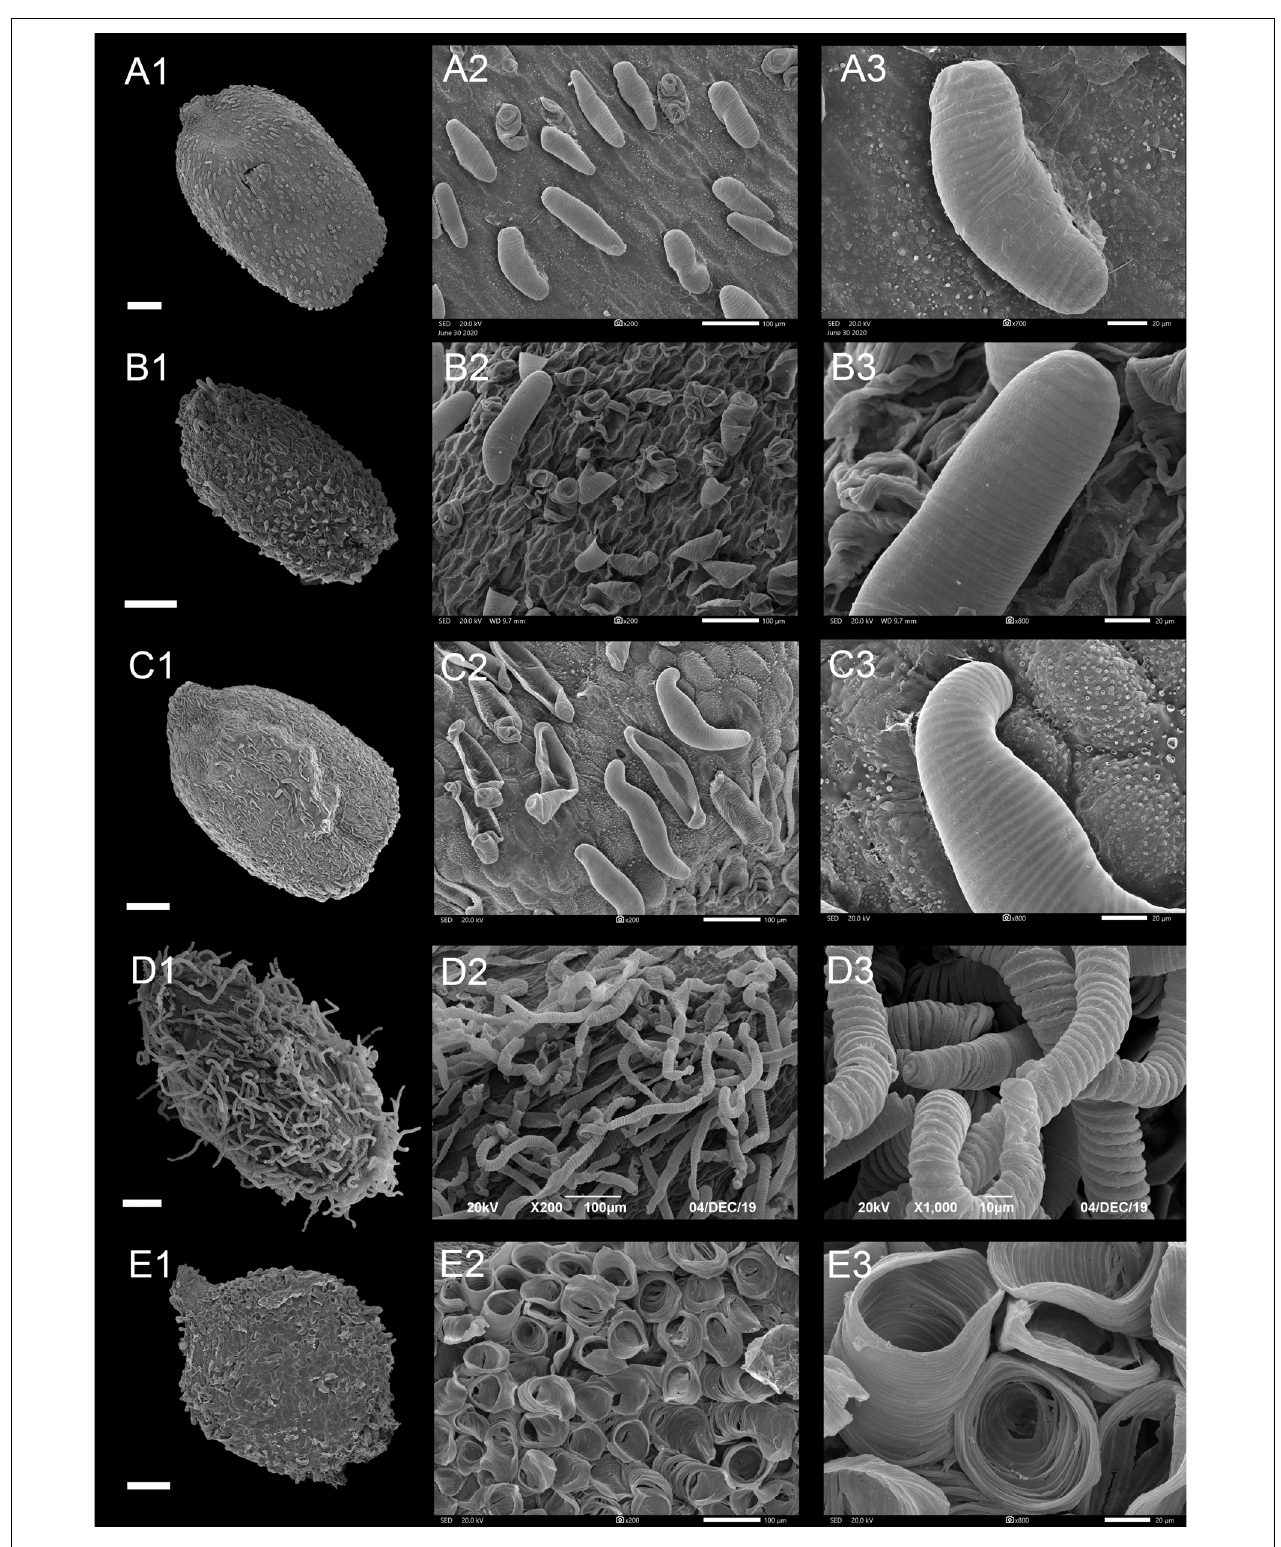
FIGURE 6 | Scanning electron microscope images of seeds from appendicular type of Impatiens . (A1–E1) Whole view; (A2–E2,C3–E3) Partial view. (A1–A3) Impatiens rupestris , (B1–B3) Impatiens obesa , (C1–C3) Impatiens polyneura , (D1–D3) Impatiens tripetala , (E1–E3) Impatiens burtonii . Scale bars: (A1–C1,E1) = 500 µ m, (D1) = 200 µ m.